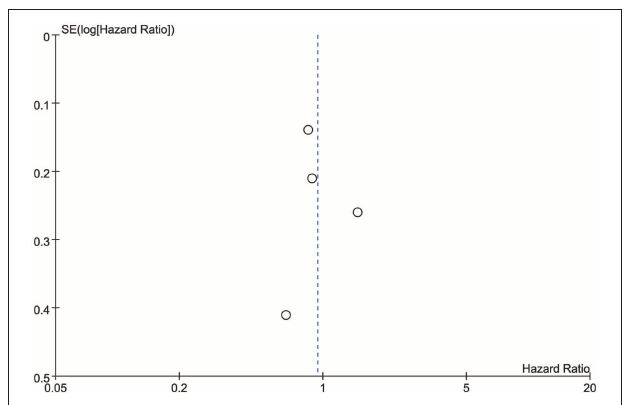
FIGURE 6 | Publication was assessed by funnel plot of overall survival.